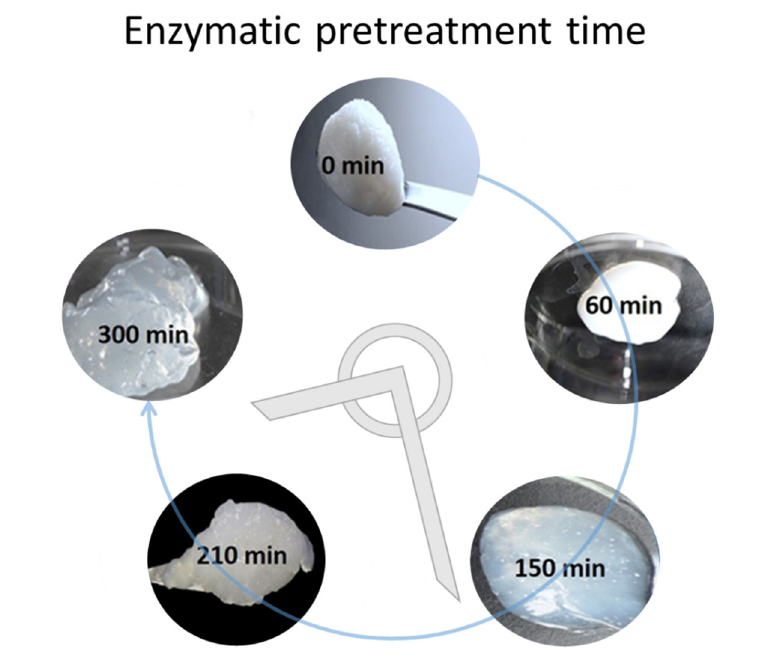
Figure 1. Images of the obtained fibril samples showing impact of enzymatic pulp pretreatment time leading to conversion from a light scattering fibre pulp to the translucent gel nature of the respective MNFC suspensions produced.